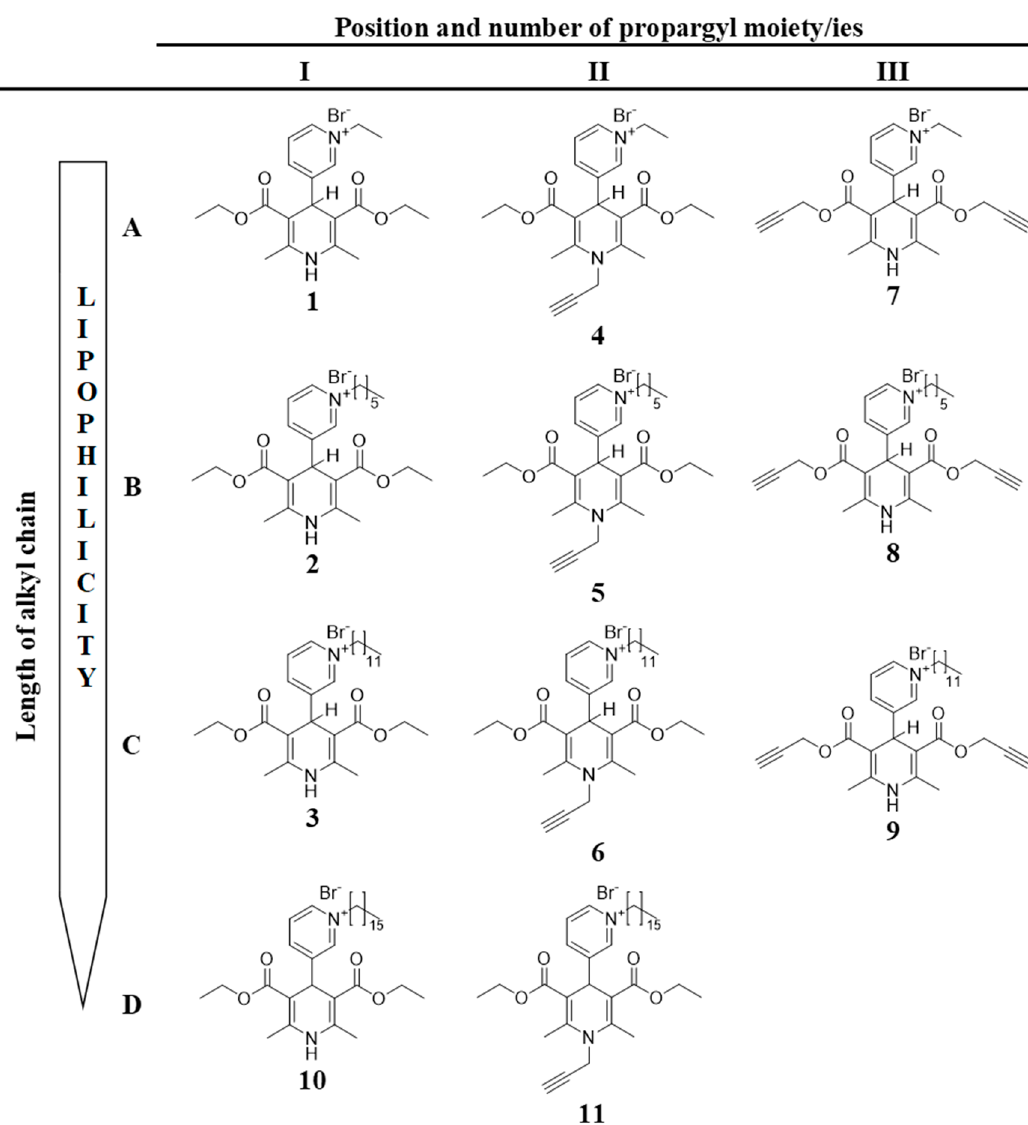
Figure 2. Structures of tested 4-( N -alkylpyridinium)-1,4-DHP derivatives 1 – 11 with variation of alkyl chain length ( A – D ) and variation of number and position of propargyl moiety ( I – III ).